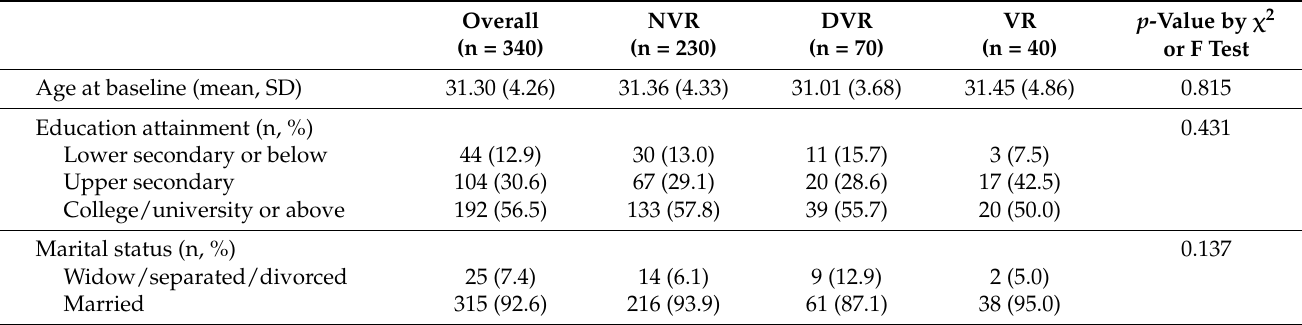
Table 2. Distributions and Mean Scores of the Study Variables, by Type of